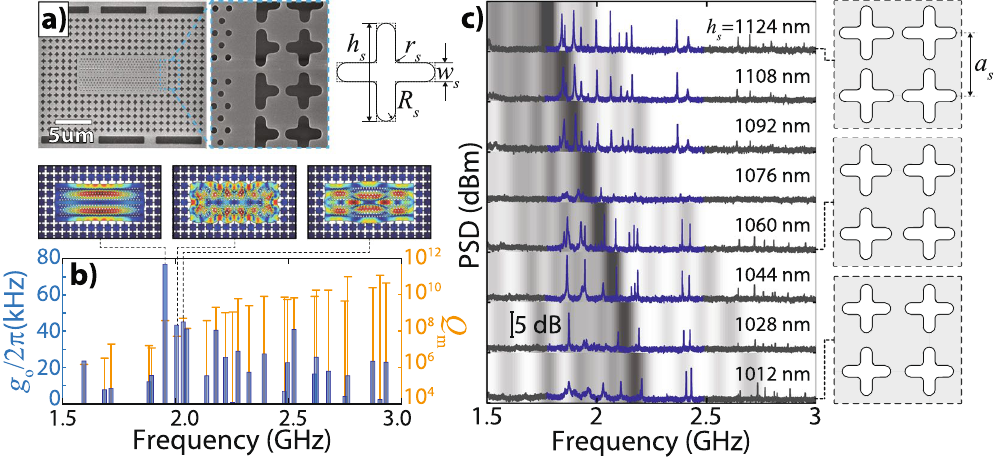
Figure 2. Optomechanical crystals ( a ) SEM images of a fabricated shielded cavity. The inset highlights the rounded shape acquired by the cross holes. The geometrical parameter definitions of the phononic shield are depicted. ( b ) FEM for the optomechanical coupling (blue bars, left scale) and mechanical quality factors (yellow lines, right scale) for the PhC surrounded by a shield with values of a s = 1265 nm, h s = 1125 nm, w s = 300 nm. We observe a logarithmic improvement in quality factors for modes inside the mechanical bandgap, which should be compared to the respective optomechanical coupling rates of each mode. The insets show the mechanical mode displacement profile for the three largest optomechanical coupling rates. The simulation only takes into account mechanical modes symmetric with respect to the central plane of the slab. ( c ) Mechanical spectra for eight different mechanical structures, whose crosses lengths ( h s ) are indicated above the spectra. The shading behind them is proportional to the density of states for each structure, based on unit-cell FEM simulations. Darker (lighter) regions correspond to a higher (lower) density of states. The simulations parameters were w s = 297.4 nm, R s = 148.7 nm and r s = 29.74 nm and a changing h s , shown in every